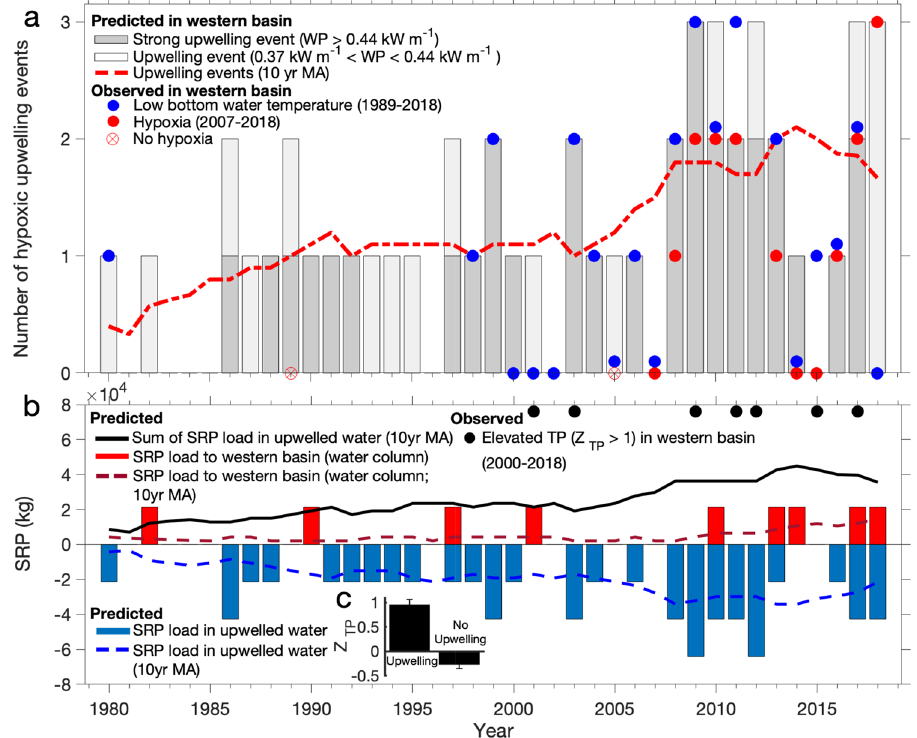
Figure 4. Number of hypoxic upwelling events in the western basin. ( a ) The number of hypoxic upwelling events based on patterns in wave power at Sta. NDBC 45005 (dark grey: average WP w > 0.44 kW m −1 , light grey: 0.37 < WP w < 0.44 kW m −1 ), and observed low bottom water temperature (Leamington; blue circles) and hypoxia (Sta E, W5, W6, W7, and W8; red circles) in the western basin. The water temperature data in 1980 is from Bartish 42 . The red crossed circles indicate the years with limited hypoxic zones (1989 and 2005) in the central basin from Zhou et al. 56 analysis during 1987–2007 (no hypoxic zone was observed in 1996 and 2007). The red dashed lines represent the 10-year moving average (10 yr MA) based on patterns in wave power. ( b ) soluble reactive phosphorus (SRP) load: the SRP load to the water column of western basin during periods of mixing (red bars) and the SRP load in upwelled water that flows back to the central basin during calmer conditions (blue bars; negative). The dashed-red and dashed-blue lines are the 10-year moving average of the SRP load to the water column of western basin and that which flows back to the central basin, respectively, and the solid- black line is the 10-year moving average of the phosphorus load to the western basin in the upwelled water (sum of dashed-red and dashed-blue lines). The black solid circles indicate August samples that had elevated TP (total phosphorus) concentrations relative to mid-July to mid-September samples in a given year (standard deviate, Z TP > 1). ( c ) Average ± standard error Z TP measured during upwelling events (n = 11) and non-upwelling periods (n = 25) taken from 5 August–8 September between 2000 and 2018 (difference was statistically significant; see